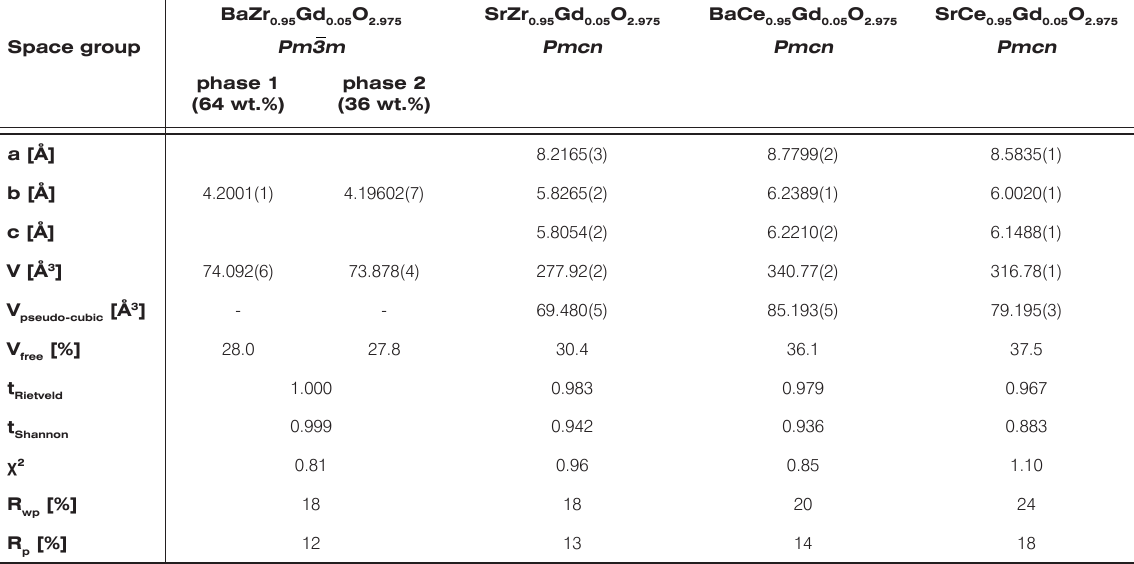
Table 1. Refined crystal structure parameters for synthesized materials (numbers in brackets denote standard